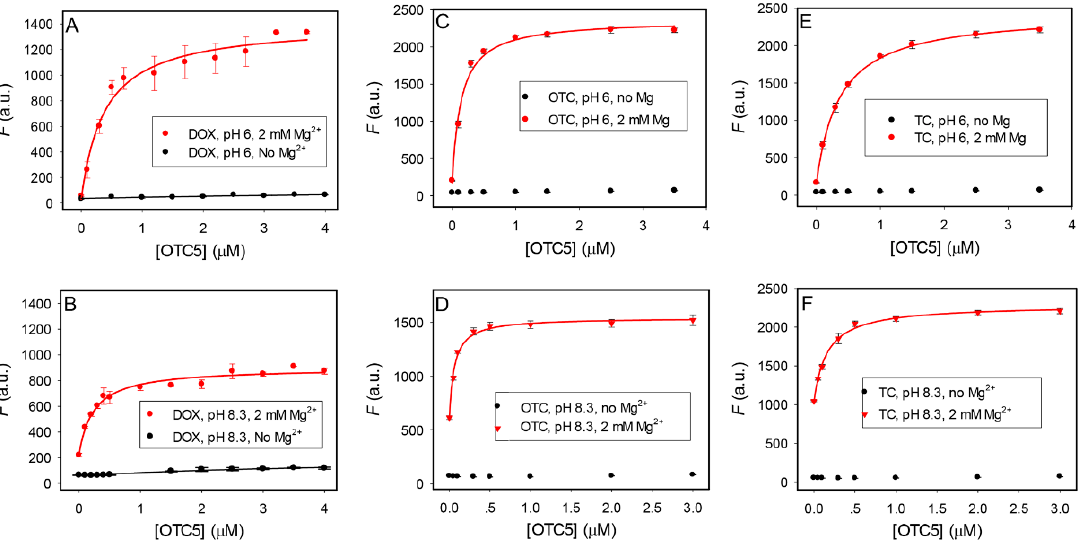
Figure 4. Aptamer binding curves for ( A , B ) DOX, ( C , D ) OTC, and ( E , F ) TC in ( A , C , E ) pH 6.0 buffer and ( B , D , F ) pH 8.3 buffers in the absence or presence of 2 mM Mg 2+ .